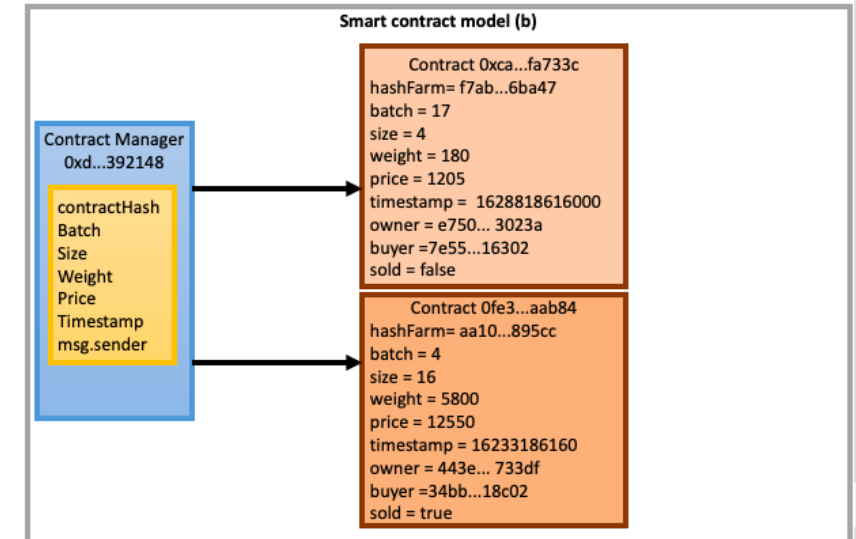
Figure 6. One smart contract for each harvest proposition.